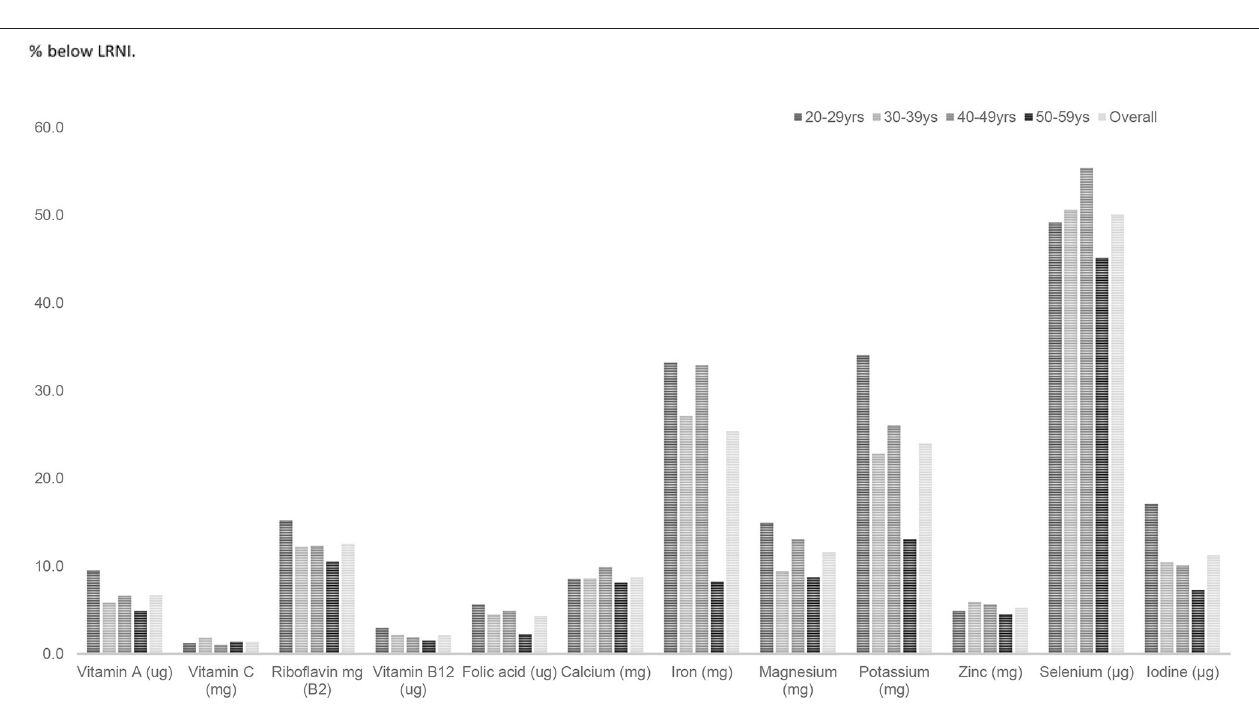
higher seminal zinc levels than their infertile counterparts